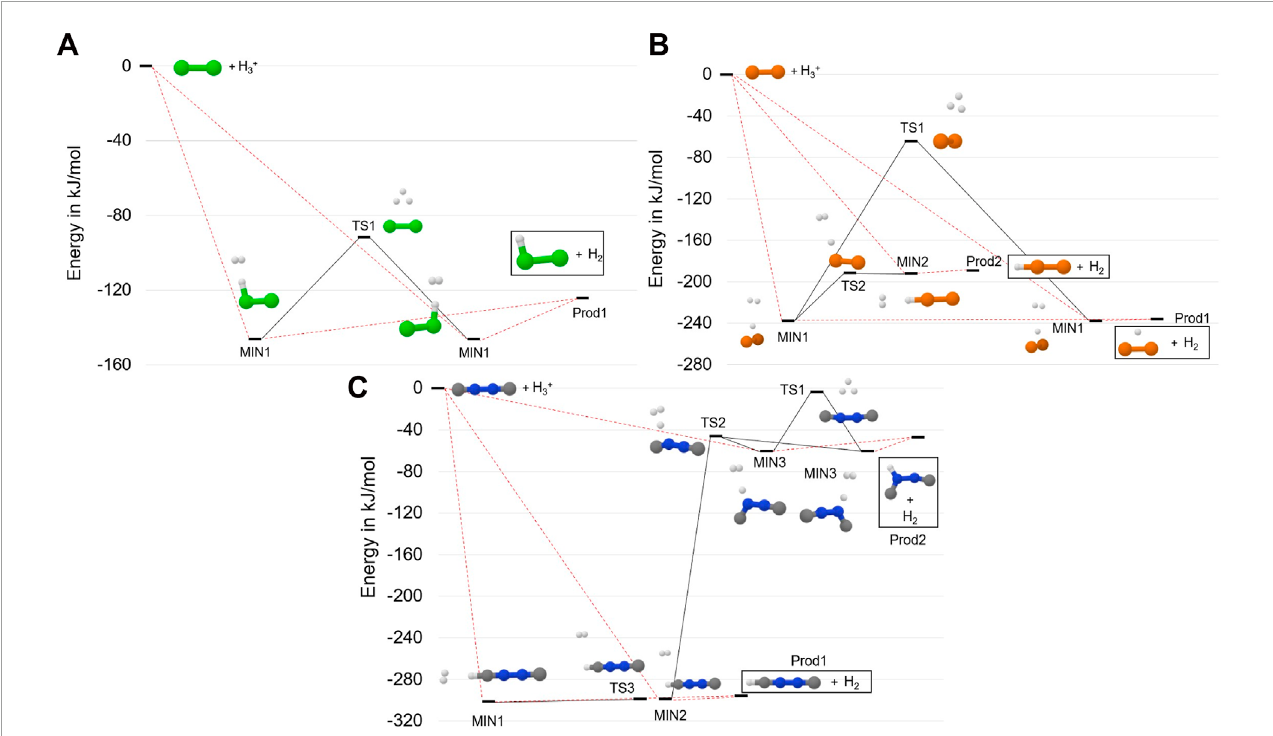
FIGURE 2 Reactive PES for: the Cl 2 + H 3 + reaction (panel A ), the P 2 + H 3 + reaction (panel B ), and the CNNC + H 3 + reaction (panel C ). The full list of stationary-point energies is reported in the SM.